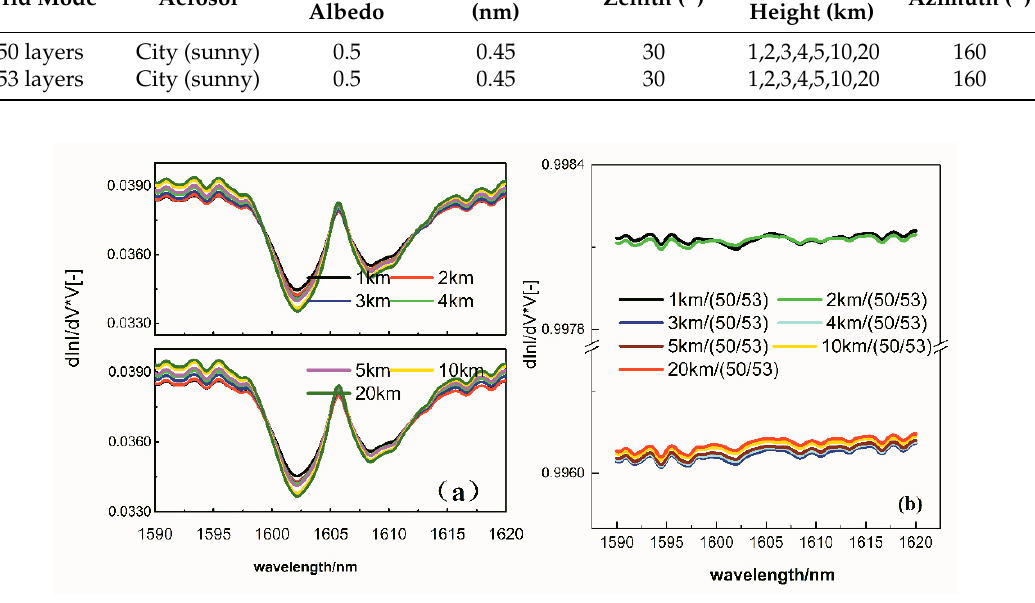
Figure 6. ( a ) CO 2 CWFs of two different vertical grid modes; ( b ) the ratios of two CO 2 CWFs at the same height.